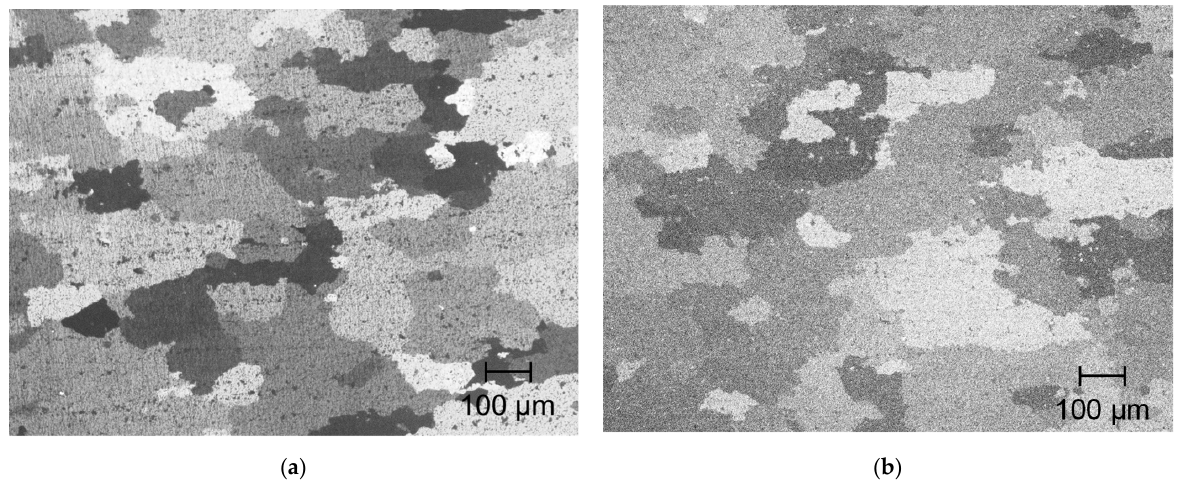
Figure 5. Optical micrographs of ( a ) 7075-T6 specimen and ( b ) 7075-annealed specimen.